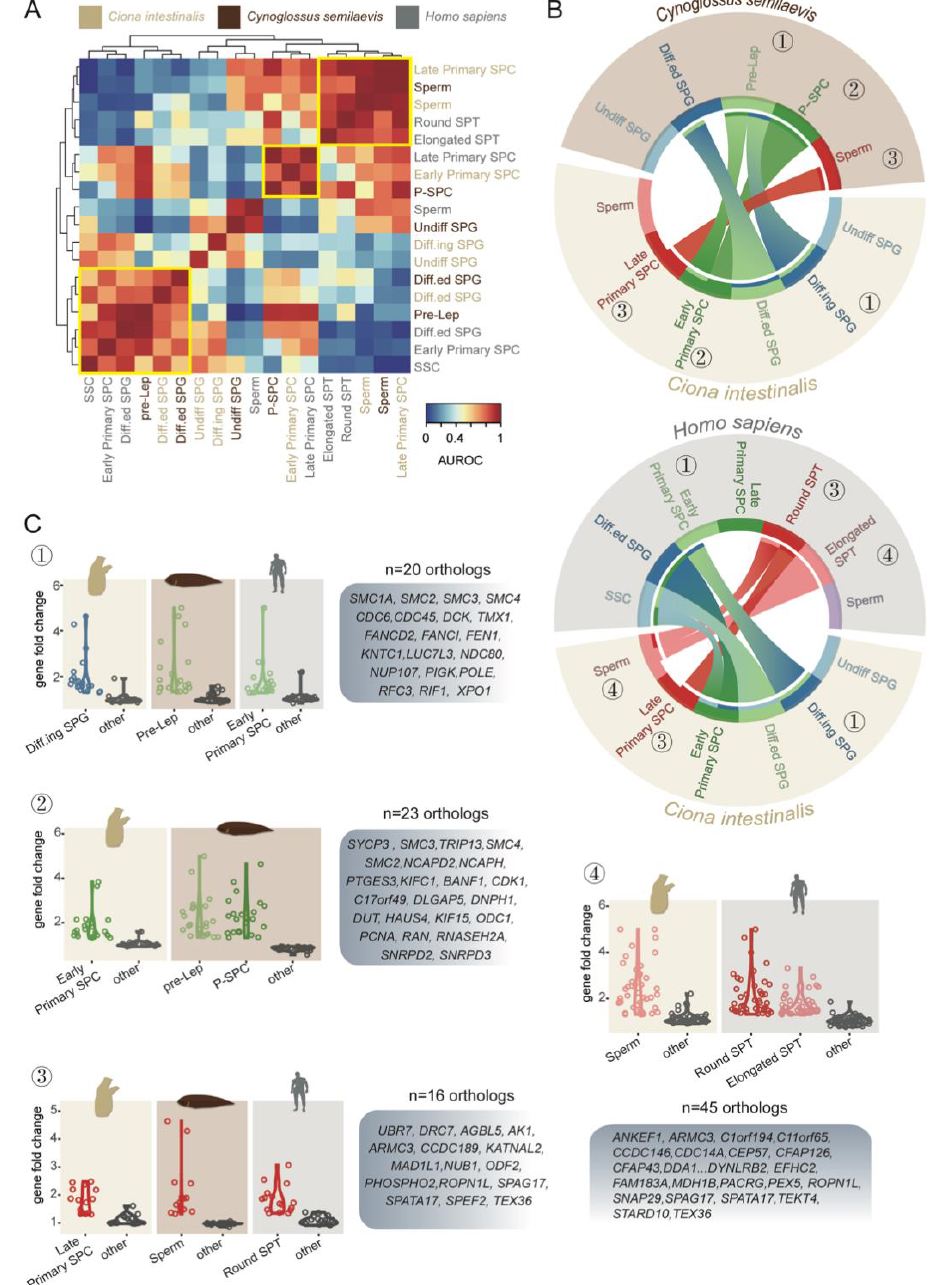
Figure 4. Conserved evolution of spermatogenesis in three chordates. ( A ) Heatmap showing ‘one versus best MetaNeighbor’ scores for germ-cell types. AUROCs are computed between the two closest neighbors in the test dataset, where closer neighbors will have higher scores. SSC: spermatogonial stem cell; Round SPT: round spermatid; Elongated SPT: elongated spermatid; other abbreviations are the same as those in C. intestinalis . ( B ) Cross-species pairwise cell-type similarities between C. semilaevis and C. intestinalis and between H. sapiens and C. intestinalis based on Kullback–Leibler divergence (KLD). The top 15% of the values are indicated as arches connecting cell types (with a width proportional to the KLD similarity). ( C ) Examples of highly similar germ-cell types across species. Violin plots show the normalized expression of the top shared orthologous genes (FC > 1.3) in each cell type compared to the average expression of the same genes in all other cell types.